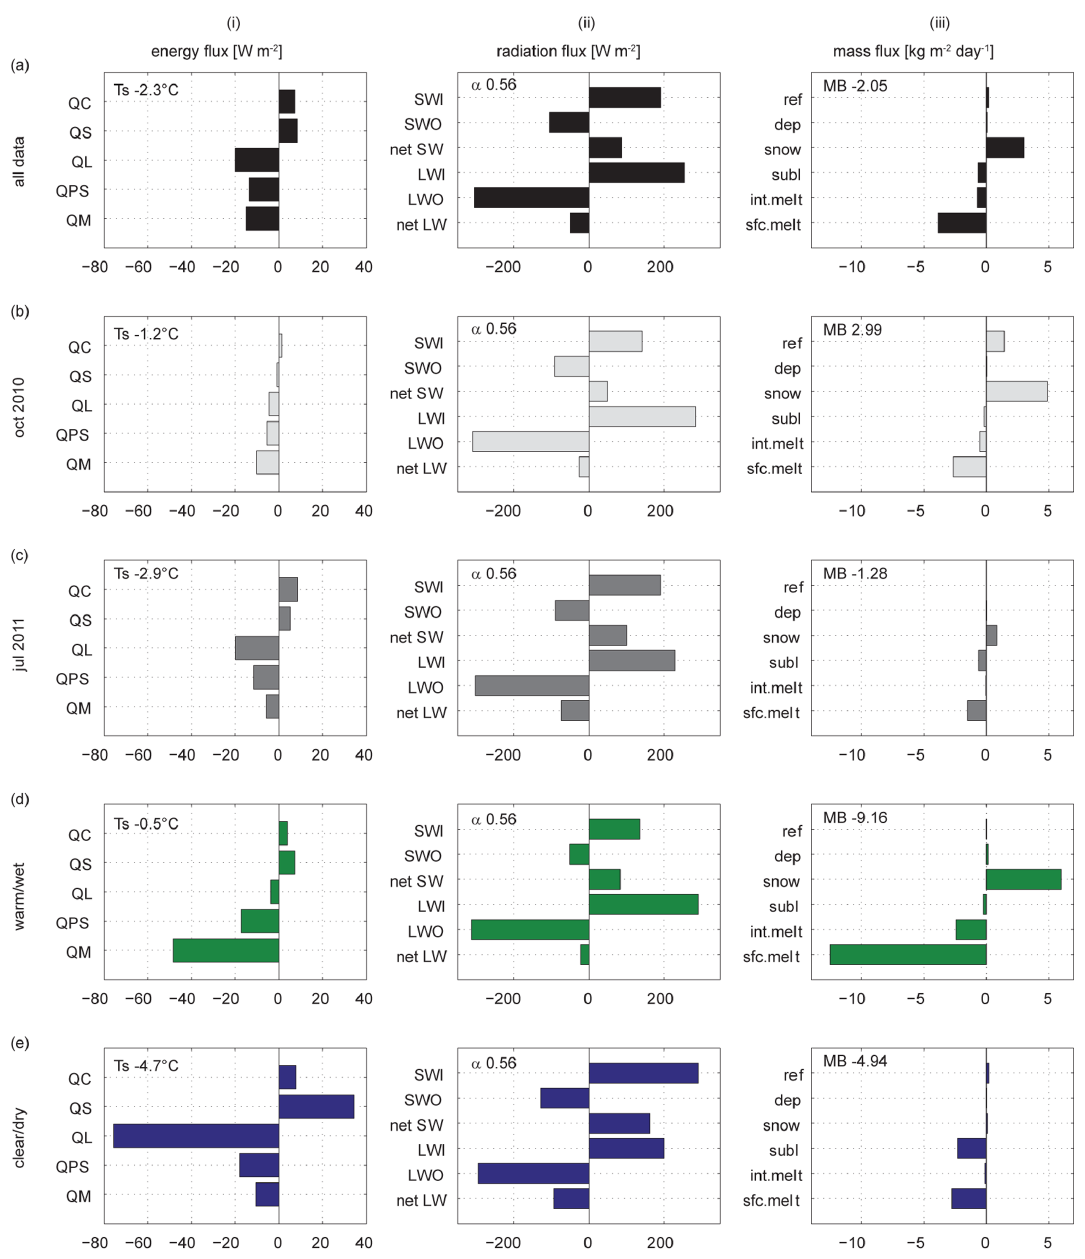
Fig. 6. Summary of (columns) (i) mean energy flux density, (ii) radiation flux components and (iii) mass fluxes at the AWS site on LG in (rows) (a) the whole modeled period, (b) standard wet conditions (1–20 October 2010), (c) standard dry conditions (1–20 July 2011), (d) 20 days of warm/wet extreme (26/04/2010–15/05/2010) and (e) 20 days of clear/dry extreme (19/01/2012–7/02/2012).